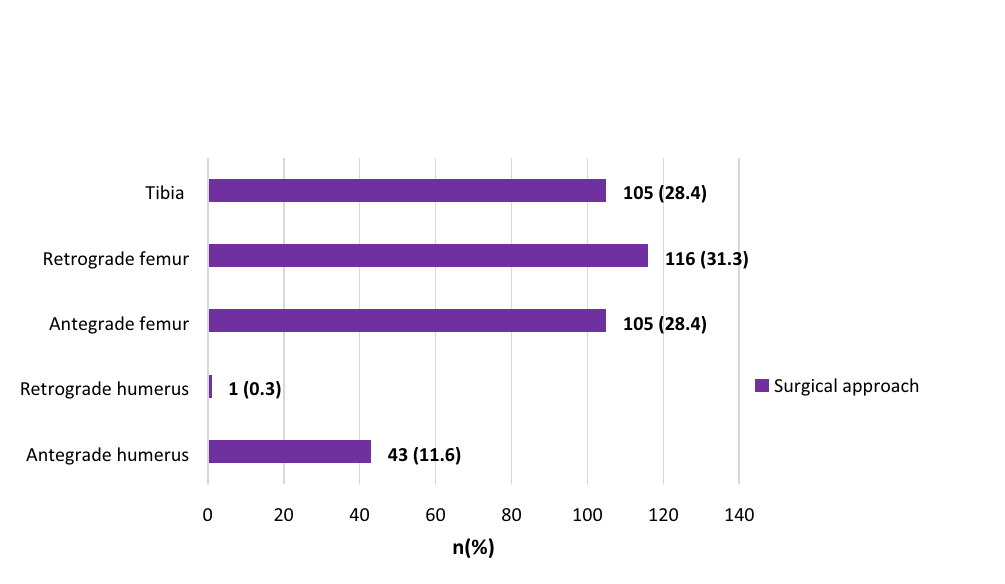
Figure 1. Surgical